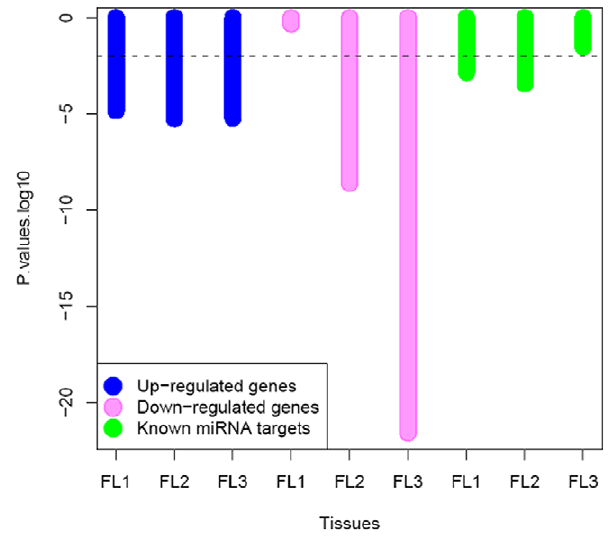
Figure 4. Known miRNA targeted genes, and genes up or down-regulated across mutants were highly abundant within the inflorescence. The inflorescence expression ranks of genes within these groups were significantly higher than ranks of genes outside these groups. Log (base 10) P values are plotted for three inflorescence tissues (FL1, FL2, and FL3). The dashed line shows an a critical value of 0.01. doi:10.1371/journal.pone.0010157.g004 PLoS ONE |